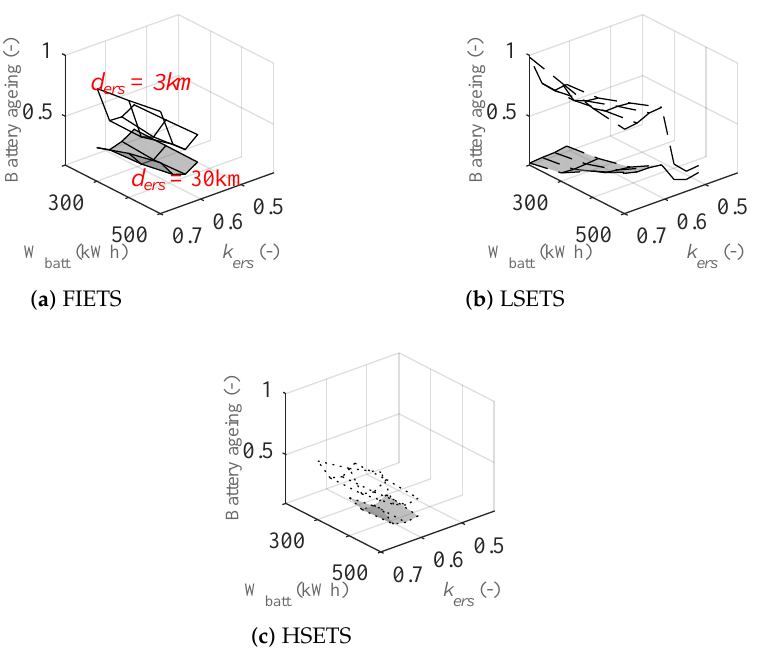
Figure 13. Relative battery ageing, ADA ERS placing over EQU ERS placing, of a long haul truck simulated on a long haul drive cycle, as a function of the battery capacity, W batt , and the ratio of ERS-coverage, k ers . The non-filled surface corresponds the ratio of the two placing methods where d ers = 3 km, the filled to where d ers = 30 km.